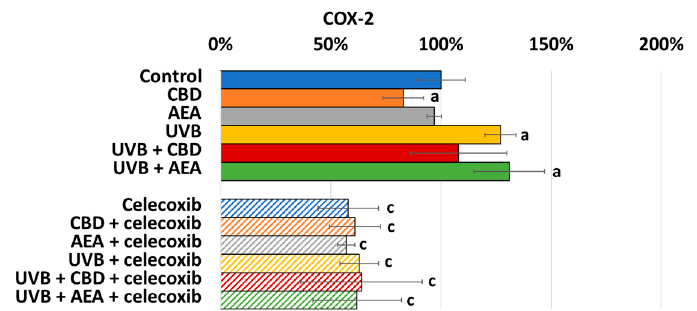
Figure 7. COX-2 activity in control keratinocytes treated with CBD (4 μ M) or AEA (4 μ M) or irradi- ated with UVB (60 mJ/cm 2 ) as well as cells irradiated with UVB and treated with CBD or AEA (in the same concentrations) as well as its expression in keratinocytes after treatment with 20 μ M celecoxib alone and with CBD(4 μ M) or AEA(4 μ M) as well as cells irradiated with UVB and treated with CBD or AEA (in the same concentrations). (a)—statistically significant differences between keratinocytes treated with CBD, AEA, UVB, UVB + CBD, AEA + UVB and non-treated cells as well as keratinocytes treated with CBD + celecoxib, AEA + celecoxib, UVB + celecoxib, UVB + CBD + celecoxib and AEA + UVB+ celecoxib and cells treated only with celecoxib; p < 0.05; (b)—statistically significant differences between keratinocytes treated with UVB + CBD, UVB + AEA, UVB + CBD + celecoxib, AEA + UVB + celecoxib and irradiated with UVB p < 0.05; (c)—statistically significant differences between keratinocytes treated with celecoxib and corresponding keratinocytes not treated with